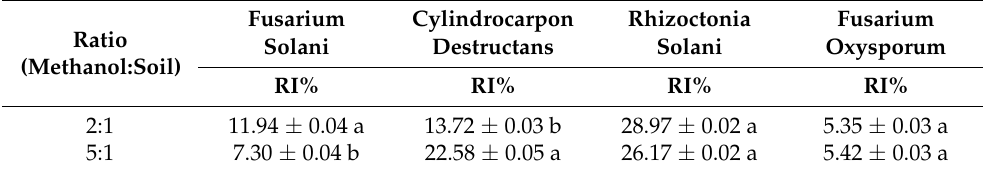
Table 3. The effect of soil extracts on the growth of American ginseng pathogens.